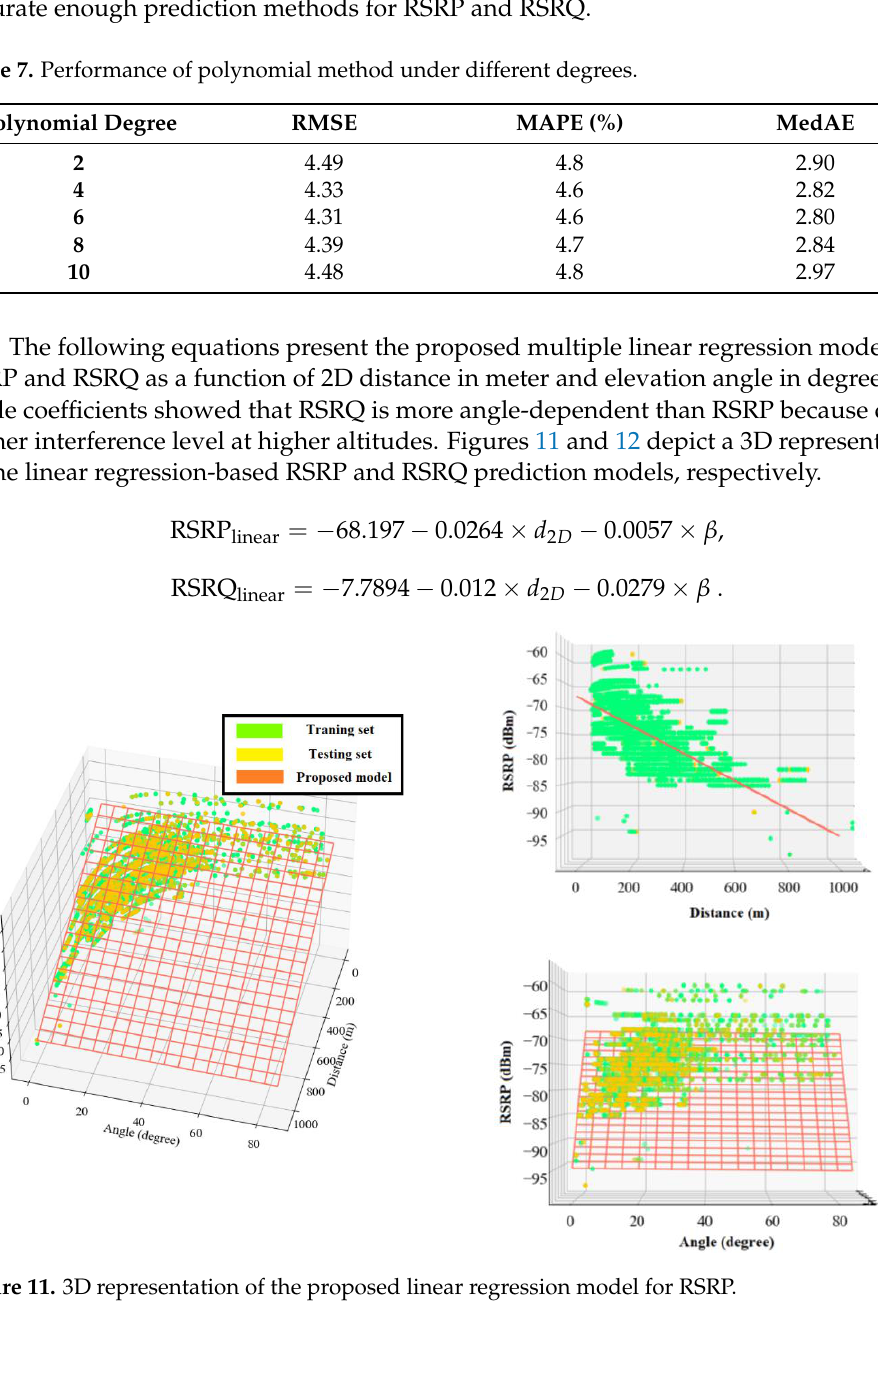
1 Figure 11. 3D representation of the proposed linear regression model for